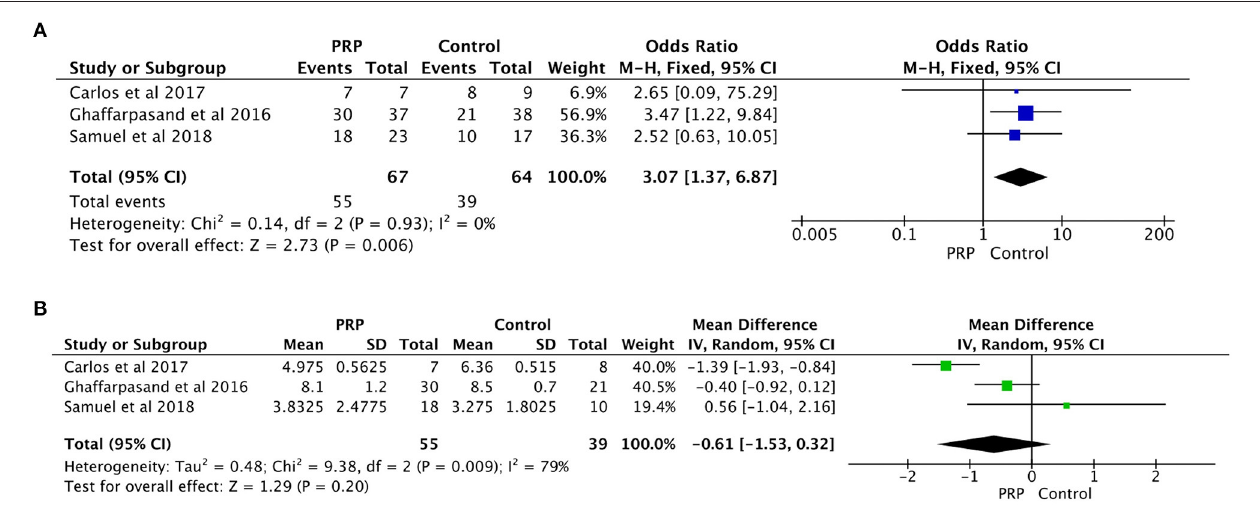
FIGURE 3 | (A) The forest plot of healing rate. (B) The forest plot of healing duration.